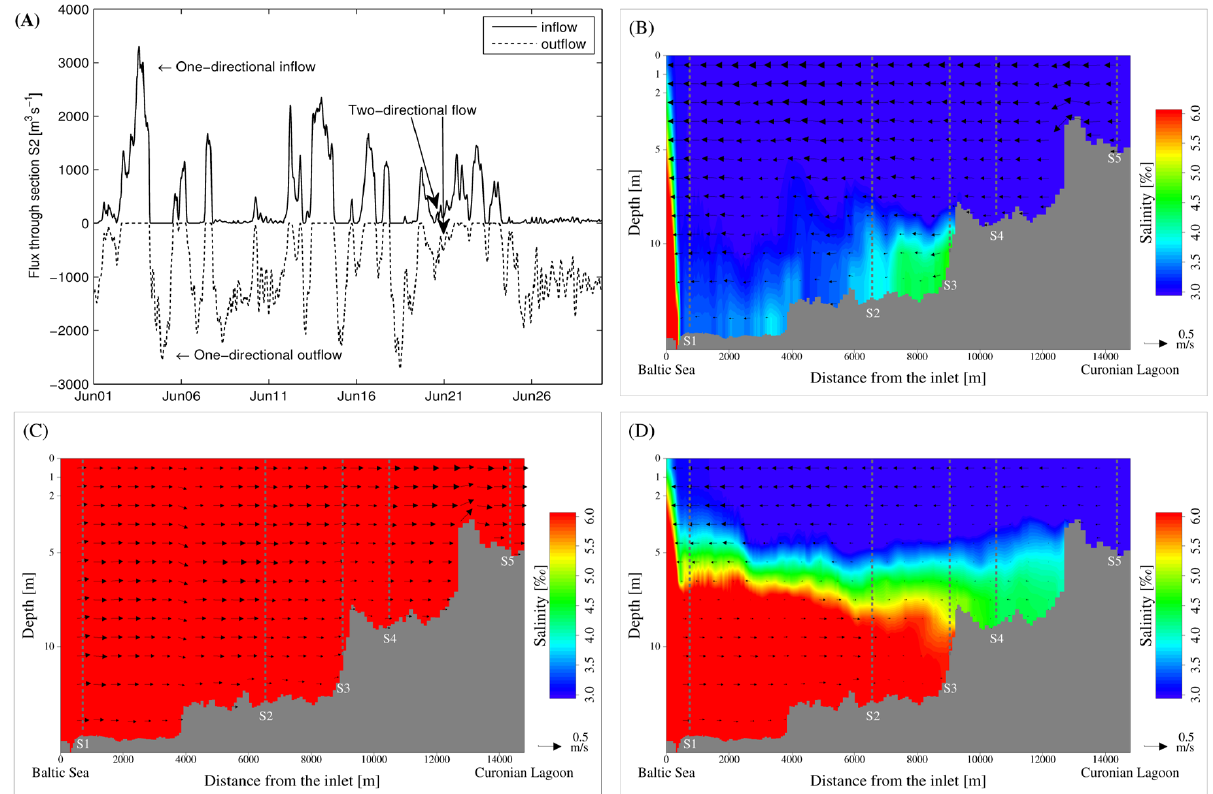
Fig. 7. Water flow through cross-section S2 in June 2009 ( (A) , continuous line for inflow and dotted line for outflow) and different flow regimes in the Klaip˙eda Strait: (B) unidirectional outflow, (C) unidirectional inflow, (D) two-layer flow. Grey dotted lines in panels (B) , (C) , (D) indicate the approximate location of cross-sections